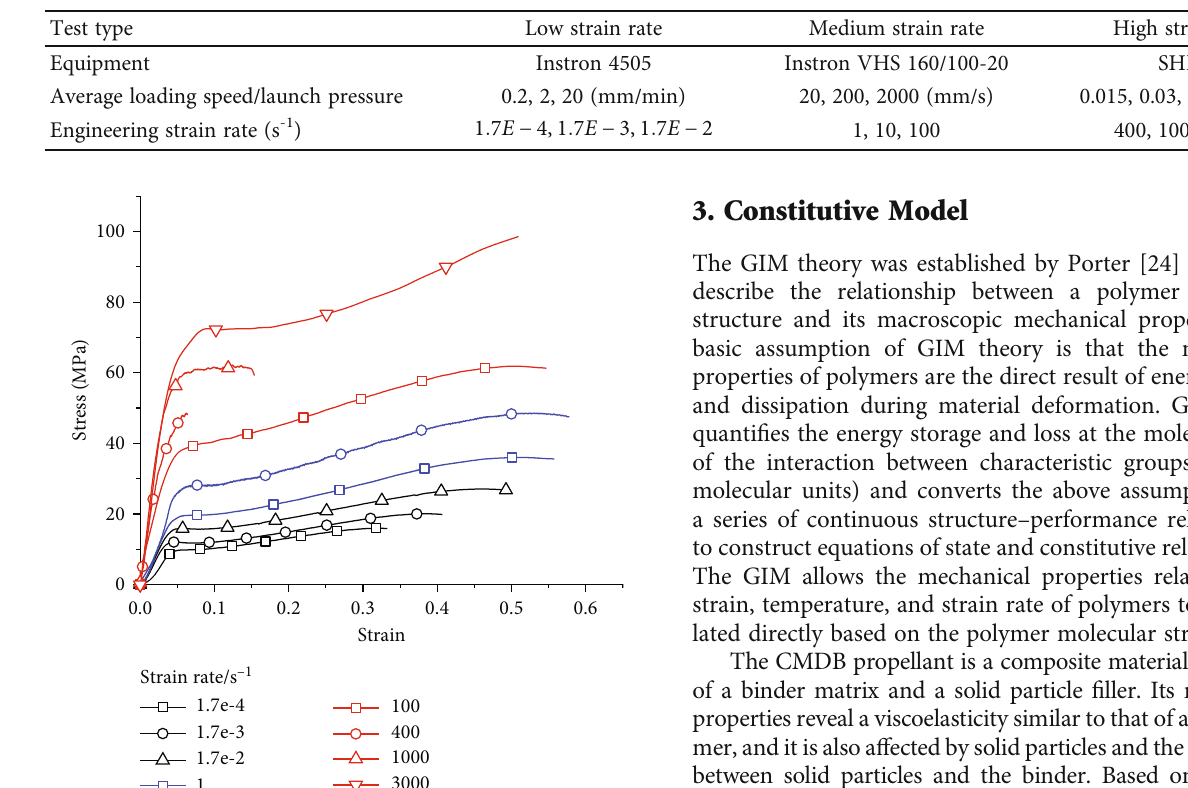
Table 2: Uniaxial compression test conditions.